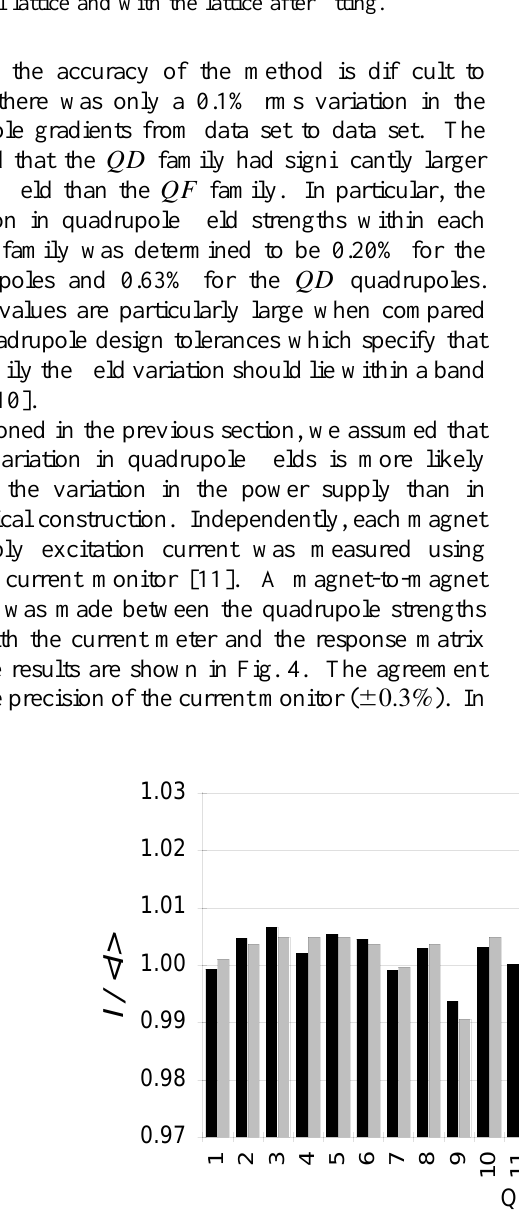
FIG. 4. A comparison of the relative variation of (cid:81)(cid:68) quadrupole strengths as measured with a current monitor and fitted response